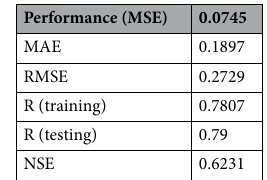
Table 12. Evaluation using SCG backpropagation.